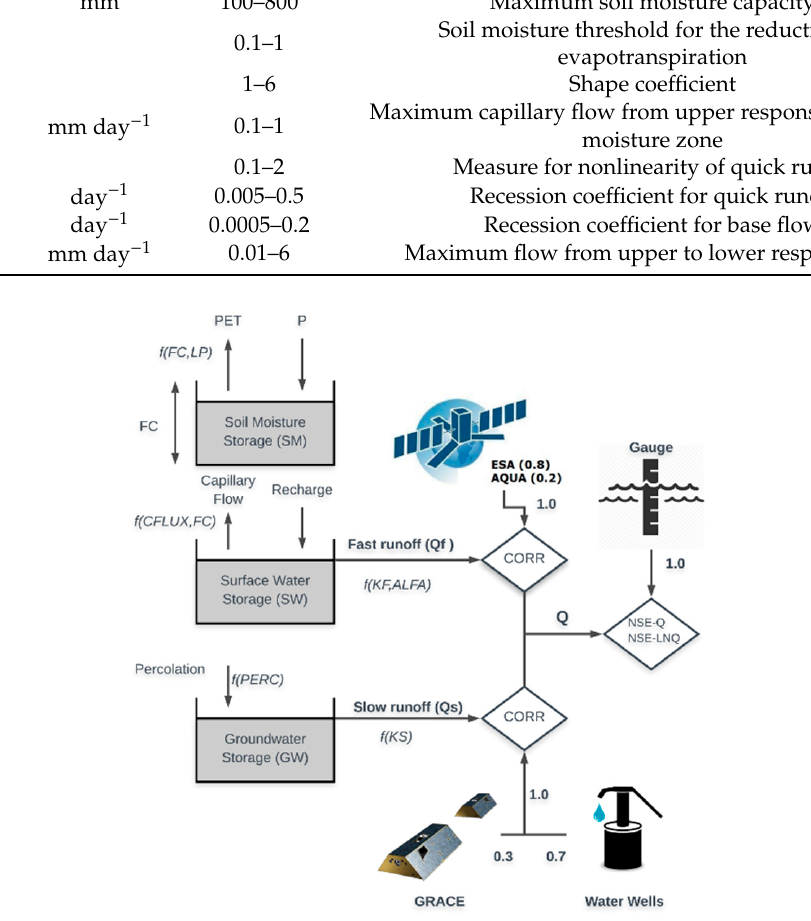
Figure 3. Conceptual diagram of the HBV model structure and evaluation procedure .